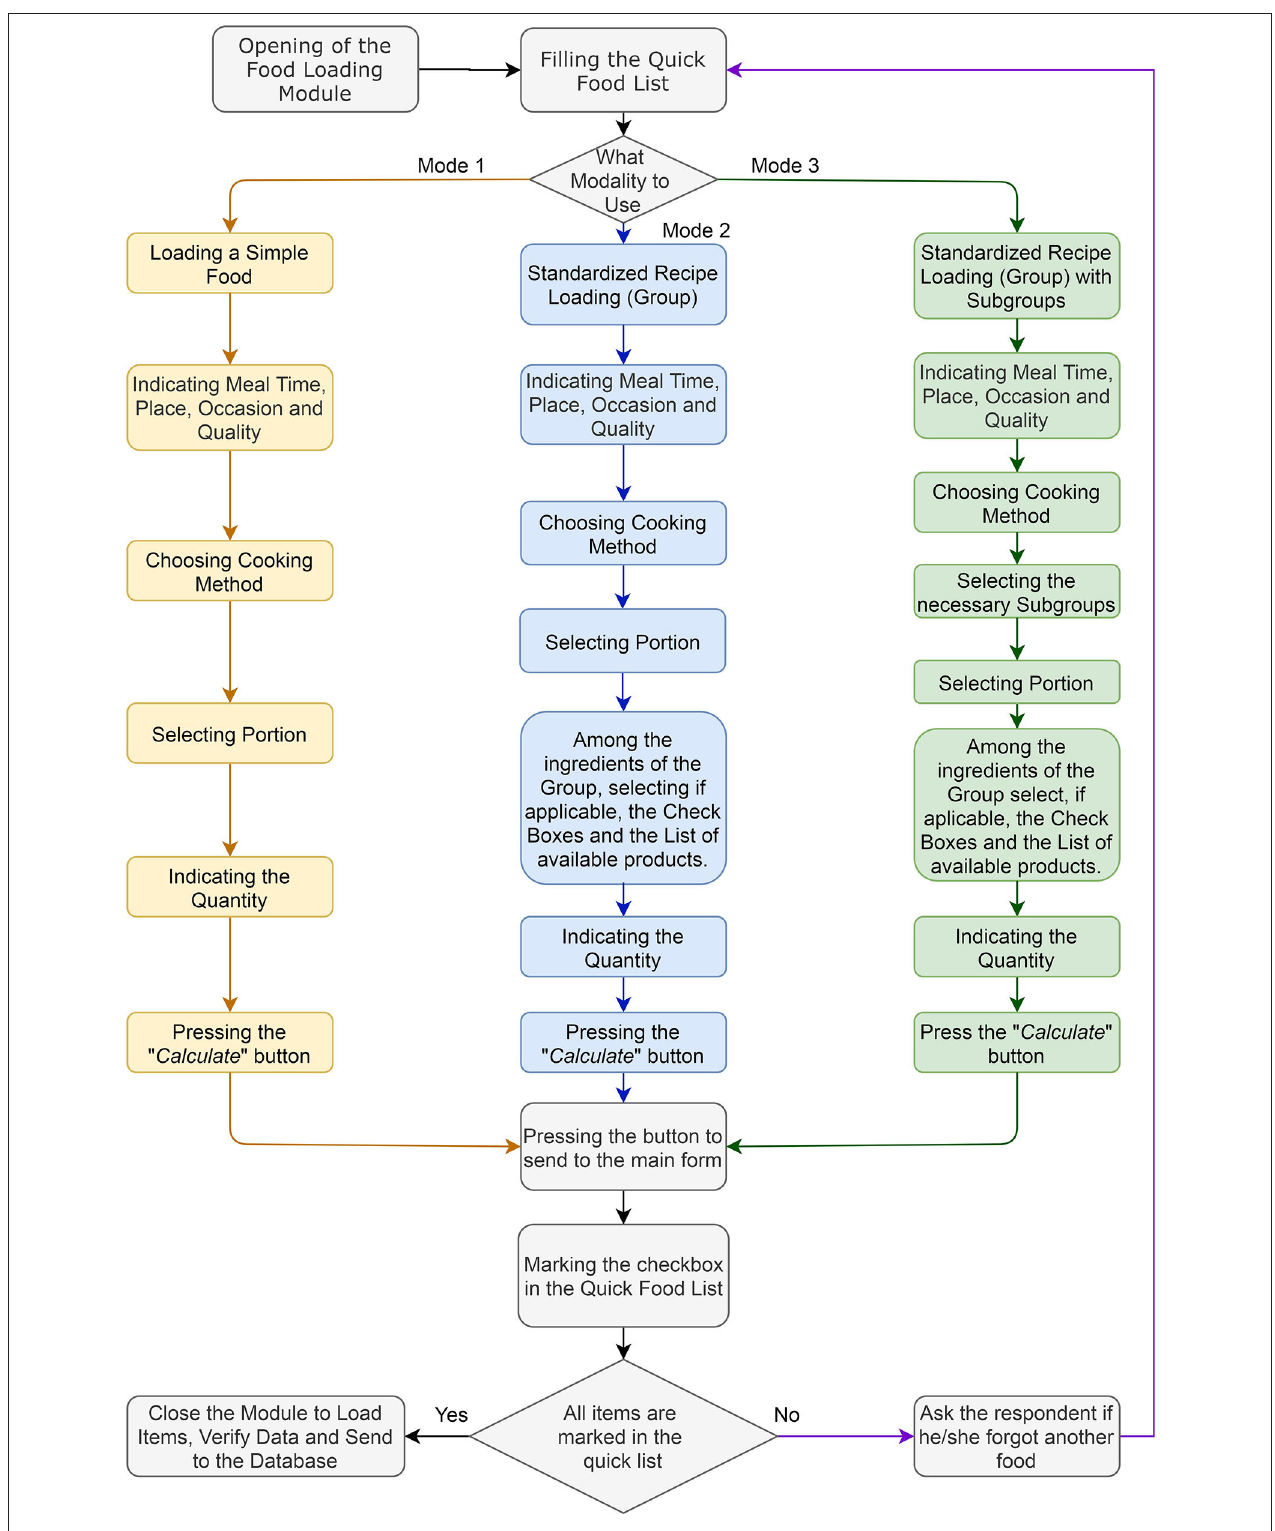
FIGURE 4 | Loading food flowchart of the